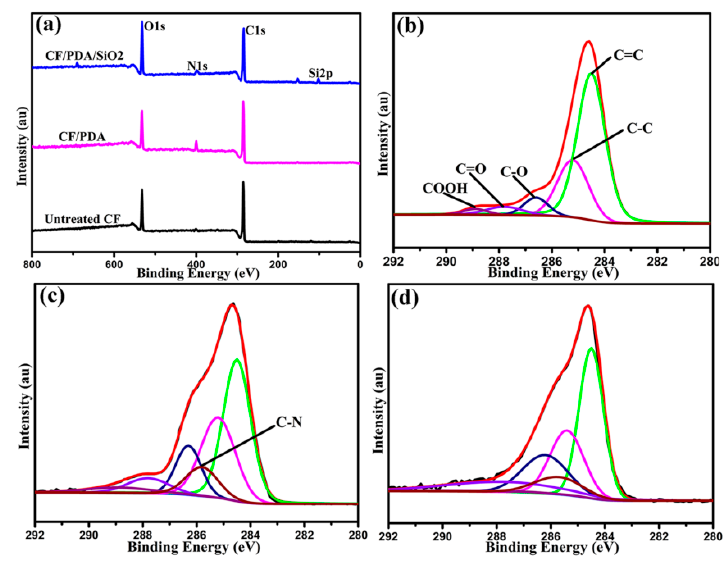
Figure 2. ( a ) Wide-scan survey XPS spectra of carbon fibers; XPS spectra of C1s peaks: ( b ) untreated CF, ( c ) CF / PDA, and ( d ) CF / PDA / SiO 2 .